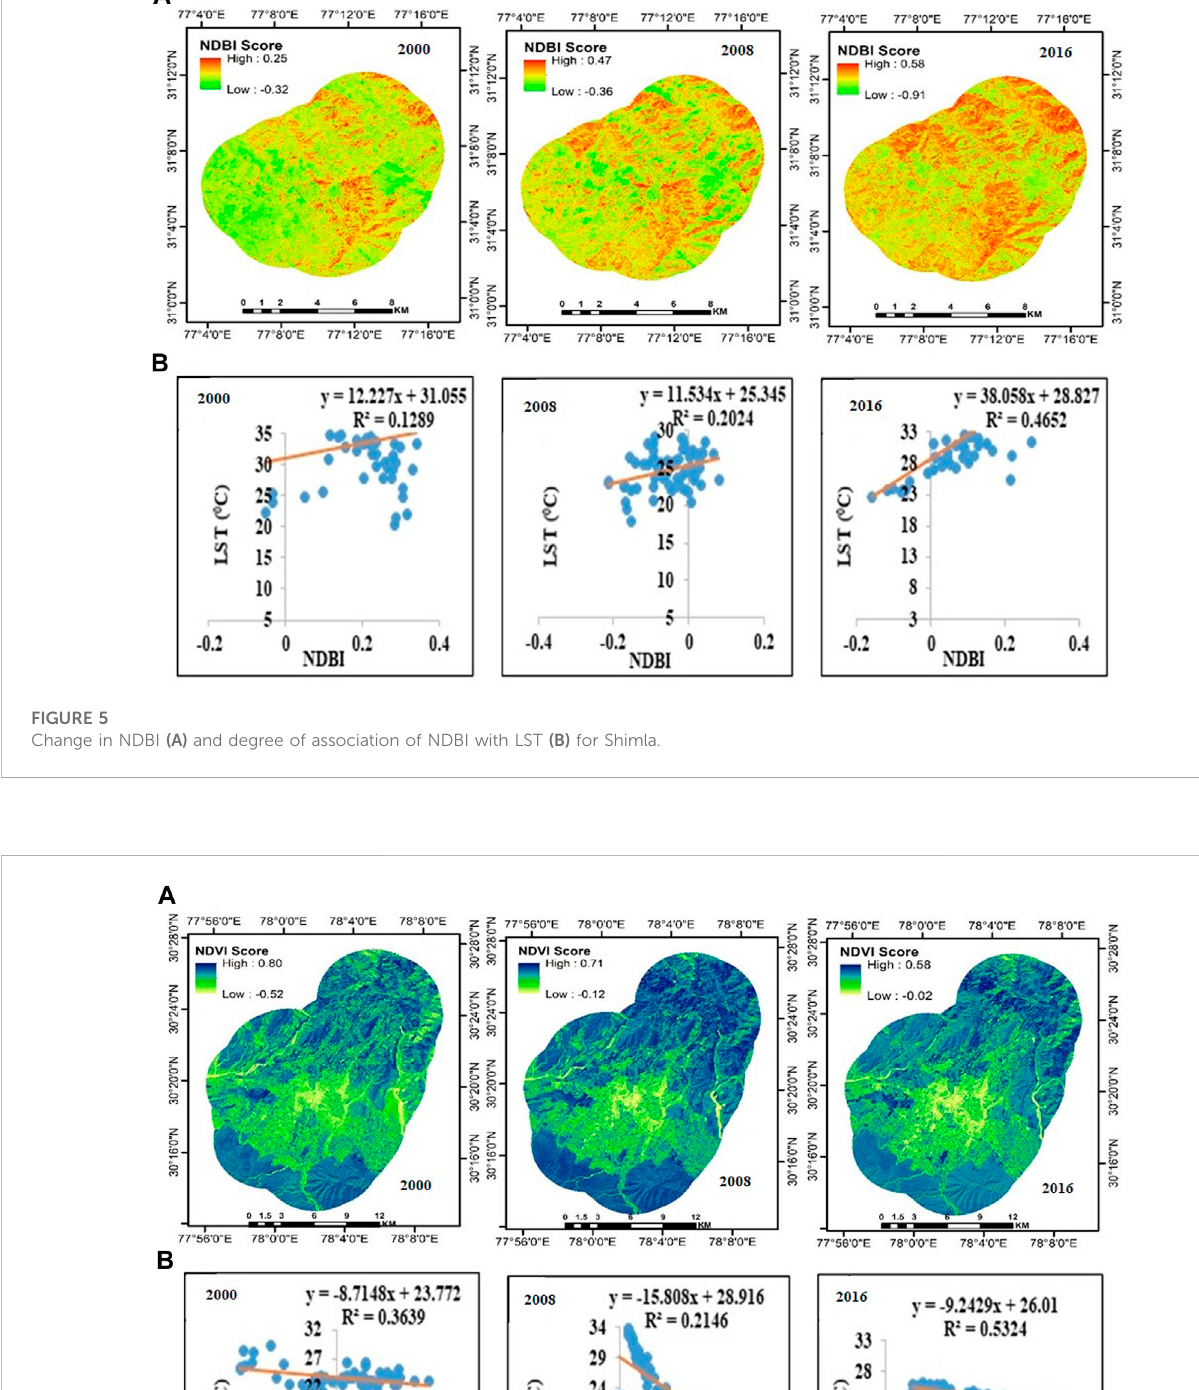
Frontiers in Environmental